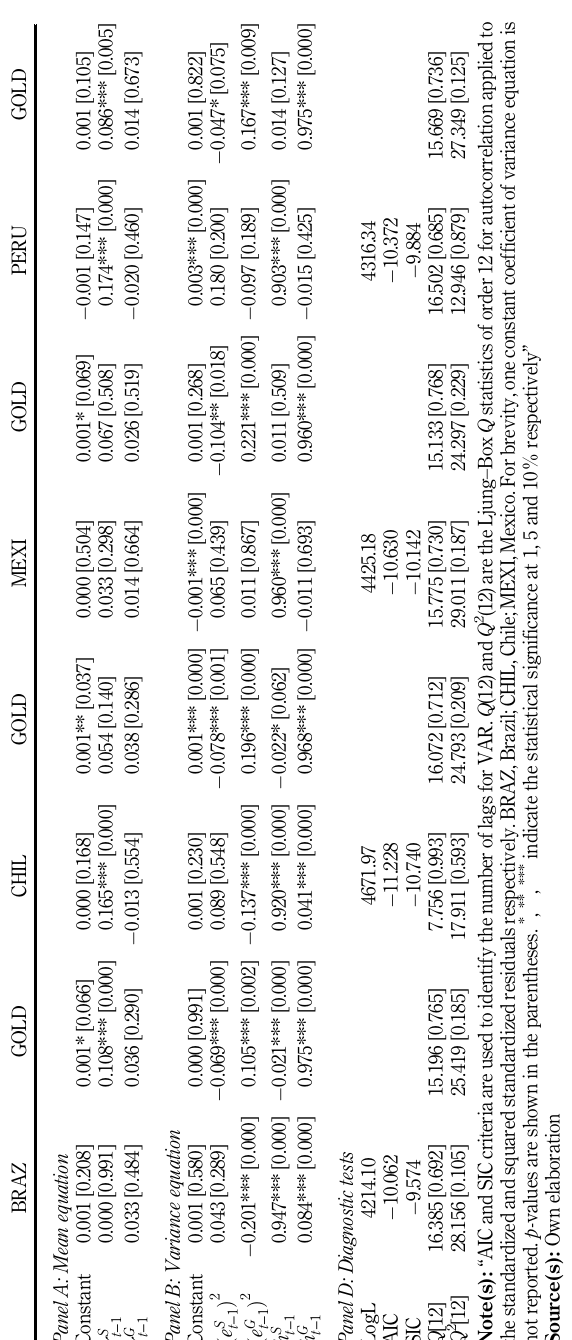
Table 4. Estimates of bivariate VAR-BEKK-GARCH for gold assets